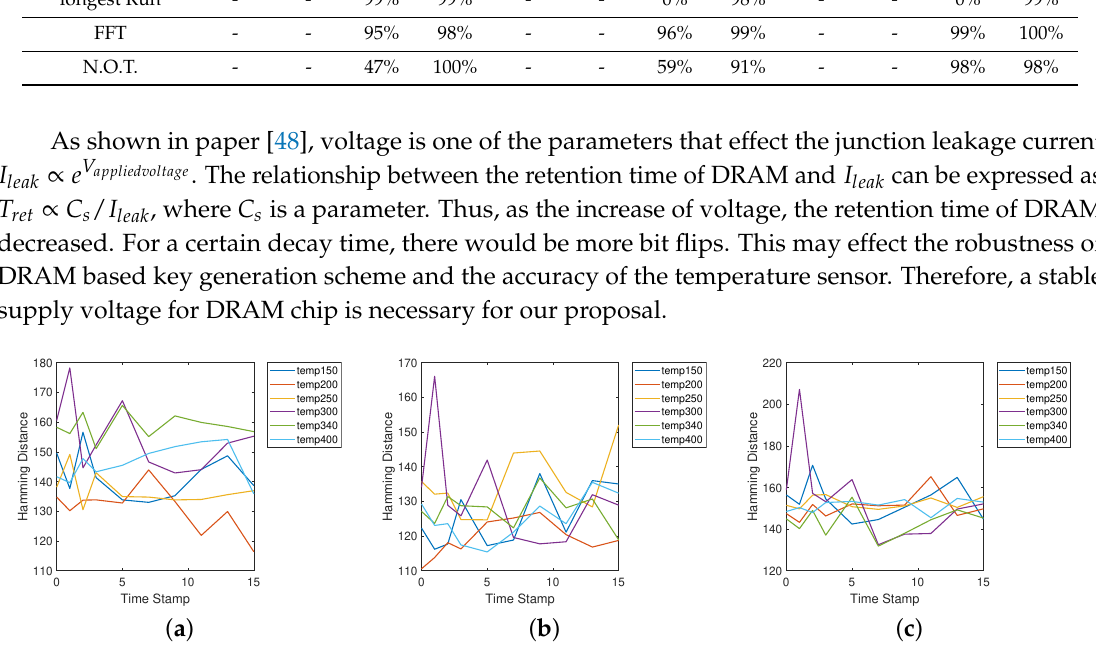
Figure 11. The aging test resuts of Rpi, Rpi2 and Rpi3. The x-ray is the days of the accelerated aging tests under 80 ◦ C. The y-ray is the Hamming distance between the output of DRAM PUF before and after accelerated aging under different temperature. ( a ) Aging test results of Rpi1. ( b ) Aging test results of Rpi2. ( c ) Aging test results of